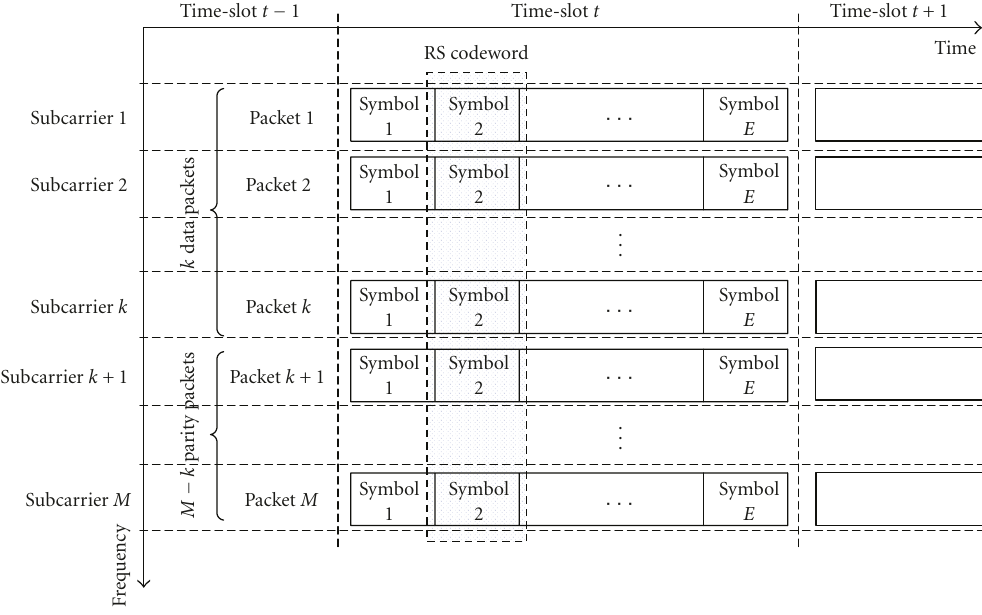
Figure 10: Transmission of RS-coded packets of ECOMP over OFDM subcarriers.